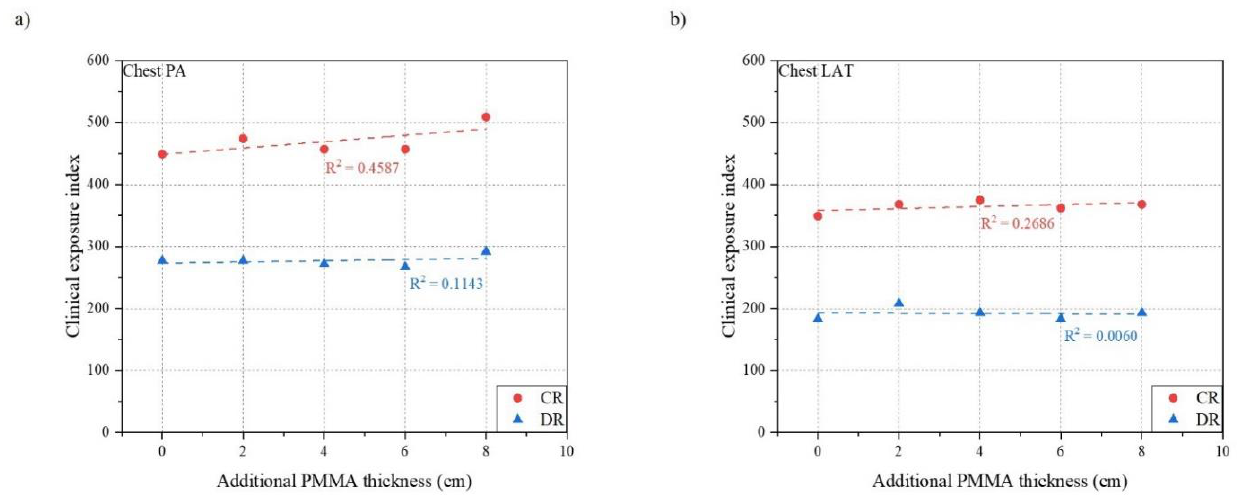
Figure 7. Relationship between phantom thickness and clinical exposure index: ( a ) Chest PA; ( b ) Chest LAT.